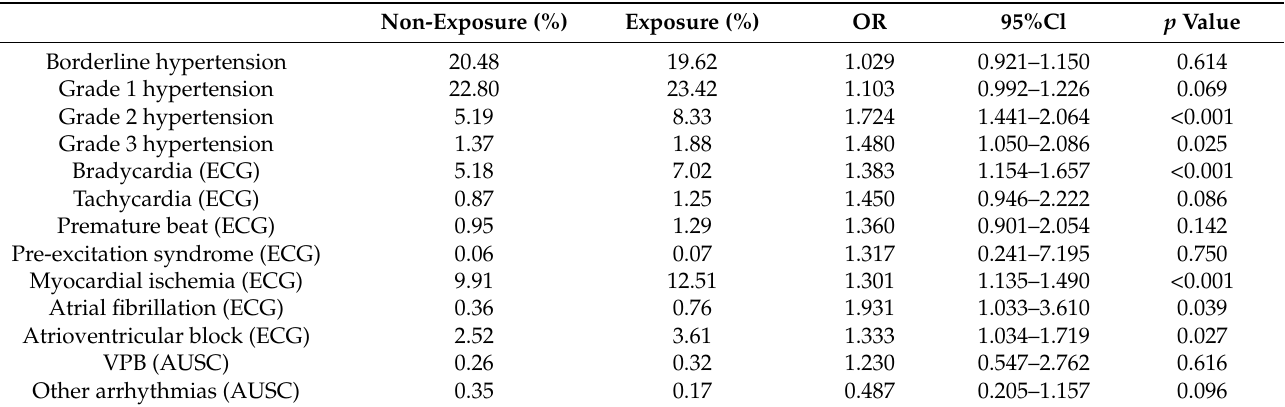
Table 2. The effects of the Great Chinese Famine on different stages of hypertension and cardiovascu- lar diseases in electrocardiogram (ECG) or auscultation